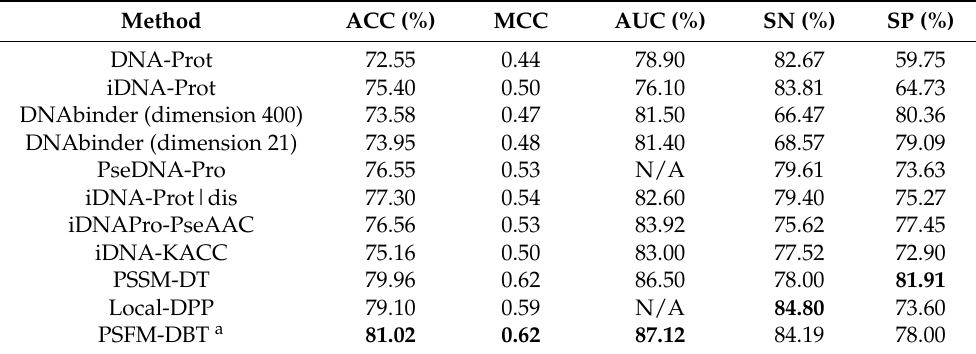
Table 2. The performance of various methods on benchmark